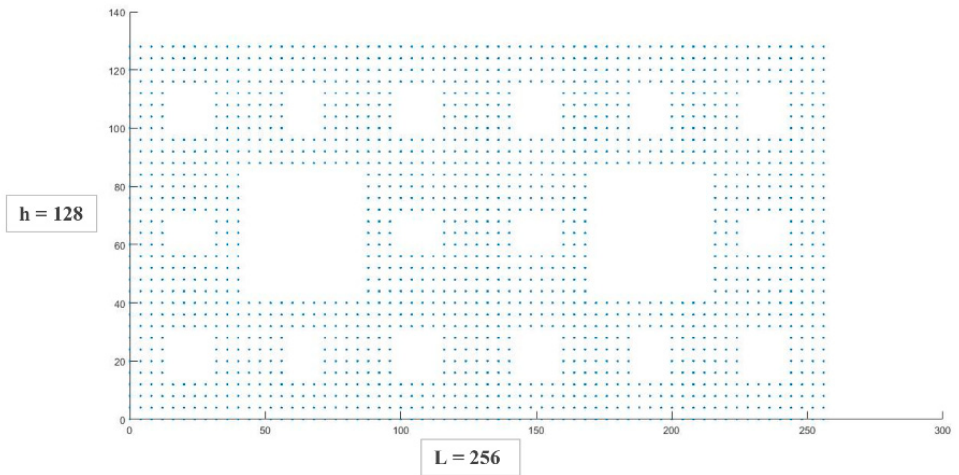
Figure 4. Front view of the beam based on Menger sponge with N = 2 iterations.